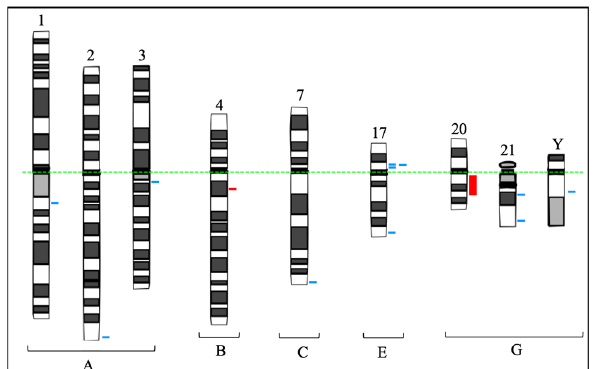
Figure 1. Ideograms of chromosomes following Denver’s group nomenclature summarizing the mapping of 13 unusual and clinically significant CNVs, identified by CMA in 7/8 MDS patients with karyotypes without numerical or structural chromosomal changes. Legend: Blue lines indicate CNVs with genomic gains, while red lines indicate CNVs of genomic loss. A dotted green line was added to indicate the alignment of chromosomes by centromeres.